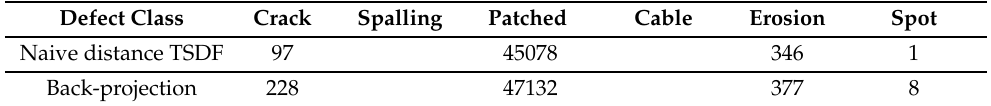
Table 5. Result of recovery class voxels.